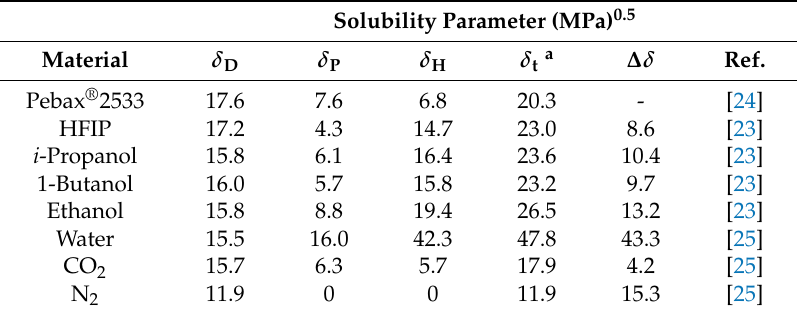
Table 7. Hansen solubility parameters (HSPs) of Pebax ® 2533, some polar solvents, and some